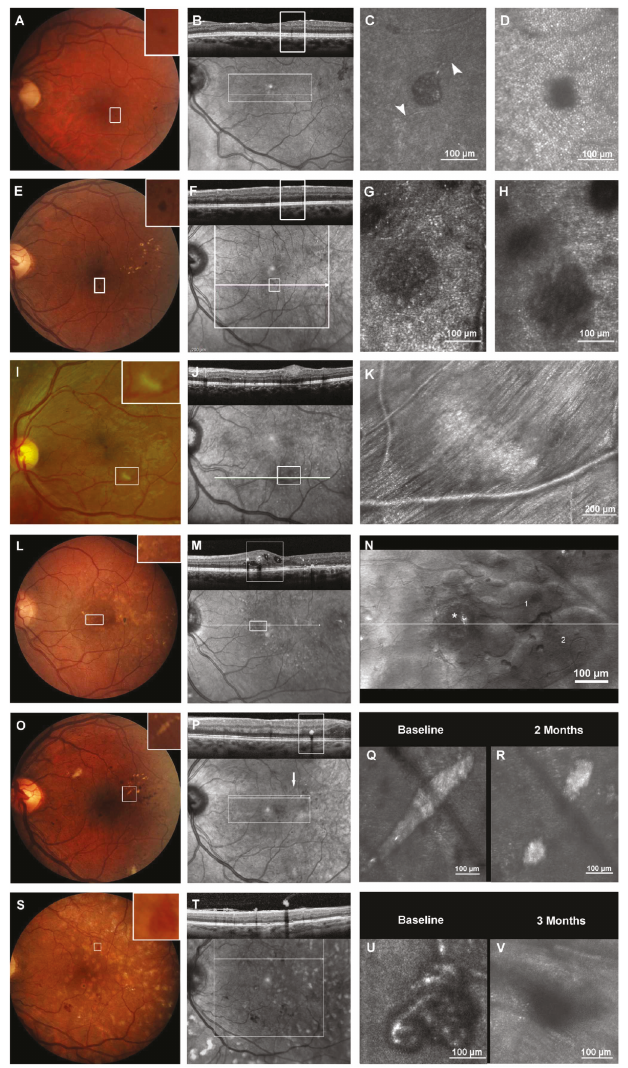
Figure 2: Multimodal imaging (color fundus photo, OCT, IR image, and AOSLO) of six hallmark lesions: a microaneurysm, MA (A – D), a blot hemorrhage (E – H), a cotton wool spot, CWS (I – K), intraretinal cysts (L – N), hard exudate, HE (O – R), and neovascular proliferation, NV (S – V). (A) Microaneurysm visible as small red dot in 30 ° color fundus photo (CF) centered on the macula. (B) In the corresponding B-scan the inner plexiform layer, MA is visible primarily by its shadowing e ff ect on the outer retinal layers. (C) In the AOSLO image focused at the vascular level, the MA is visible as a well-de fi ned saccular bulge within the capillary network. Feeding and draining vessels (arrowheads) are discernable. (D) When focused at the photoreceptor plane, shadowing from the MA is present surrounded by a clearly imaged photoreceptor mosaic. (E) Small blot hemorrhage easily visible in 30 ° color fundus photo and Spectralis IR image (F) but not clearly identi fi able in the corresponding cross-sectional SDOCT B-scan. G Outlines of the hemorrhage are blurred even in the AOSLO image focused at the hemorrhage plane. (H) When focused on the photoreceptor plane, there is shadowing of the photoreceptor mosaic by the anteriorly located blot hemorrhage. (I) CWS clearly visible in 30 ° Optos color fundus image and Spectralis IR image (J). In the corresponding SDOCT B-scan, the CWS appears as a nodular thickening of the retinal nerve fi ber layer (RNFL) compressing the inner plexiform and inner nuclear layer. Notice the faint shadowing e ff ect on the outer retinal layers. (K) Montage of 17 AOSLO images focused at the RNFL level to cover an area of 3 ° × 4.5 ° . The CWS appears hyperre fl ective with a less clearly delineated nerve fi ber striation pattern compared to adjacent areas. Nerve fi ber bundles adjacent to the CWS are pushed aside at the lower right border of the lesion. (L) DME is not evident on the 30 ° color fundus and Heidelberg Spectralis IR (M) photographs, but is clearly visible on the montaged MSL AOSLO images (N) and corresponding SDOCT B-scan. The white boxes in (L) and (M) correspond to the area imaged on AOSLO (N). An asterisk marks a microaneurysm and [1, 2] indicates corresponding cysts in the AOSLO (N) and SDOCT (M) images. (O) The HE is clearly visible on color fundus photography (O) OCT and IR image (P). In confocal AOSLO images (Q), the HE appears as a hyperre fl ective granular structure with an internal honeycomb-like pattern. Two months after intravitreal ranibizumab injections for center involved diabetic macular edema, the HE decreased in size to reveal an intact photoreceptor pattern. (S) Fundus photograph of neovascularization elsewhere (NVE) that is clearly visible on OCT and IR image (T). (U) Corresponding NVE imaged with AOSLO before treatment (U) and 3 months after administration of intravitreal ranibizumab (V). AOSLO imaging reveals the persistence of an involuted neovascular